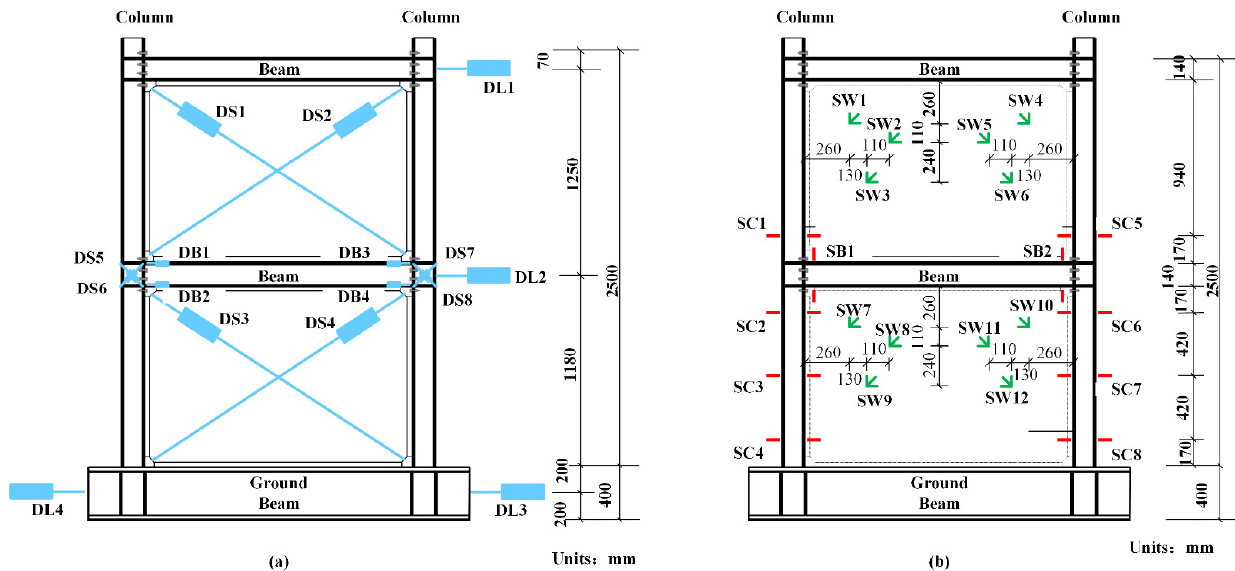
Figure 6. Plan of measuring points: ( a ) positions of displacement meters; ( b ) positions of strain